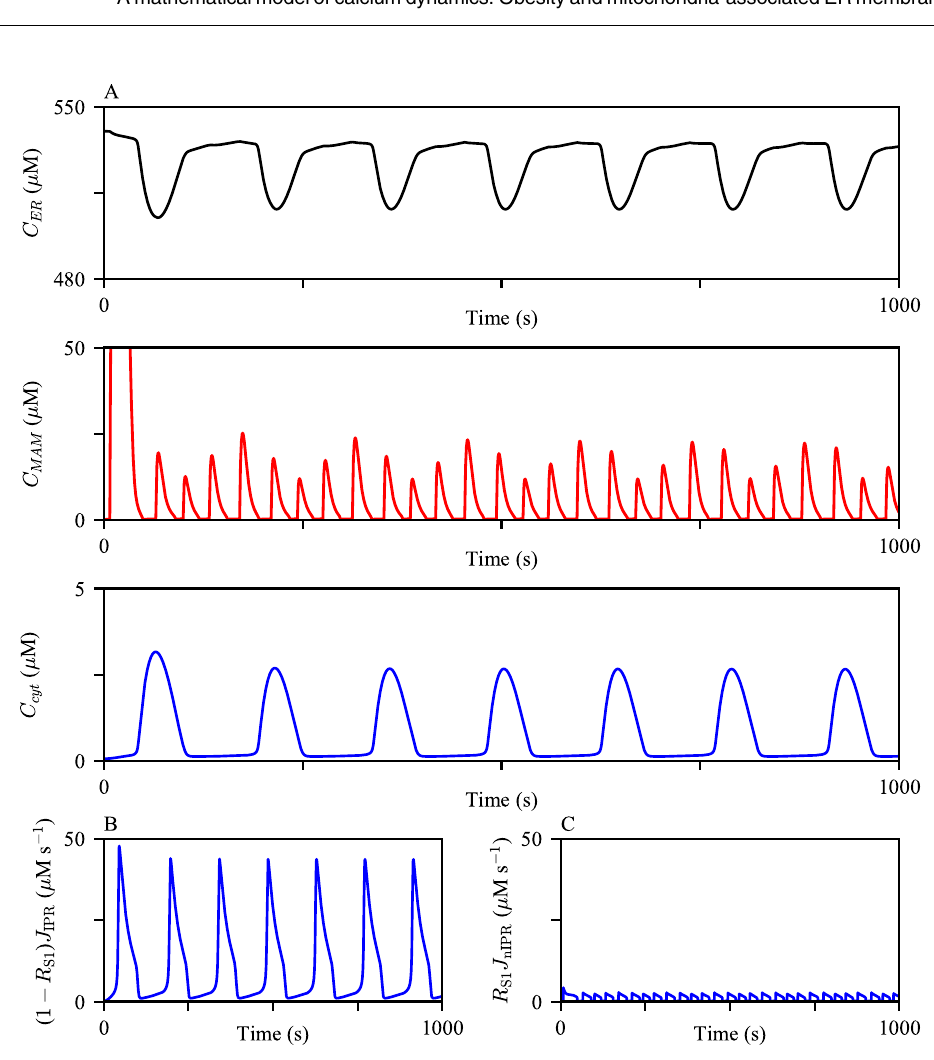
Fig 4. Ca 2+ oscillations generated from the model exhibit varying orders of magnitude in different compartments. (A) The model was given continuous stimulation of IP 3 with P s = 0.3 μ M. From the top, the panels show Ca 2+ oscillations in the ER, the MAM, and the bulk cytosol. (B and C) The magnitudes of IPR Ca 2+ fluxes from the ER to the bulk cytosol and the MAM, respectively, during the oscillations shown in